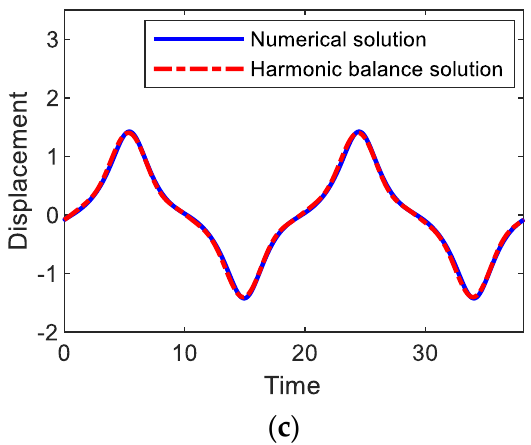
Figure 6. Comparisons between numerical and analytical solutions for ( a ) period-1 T , ( b ) 3 T , and ( c ) 5 T interwell motions, which are obtained when the amplitude and frequency of the base acceleration are given as A = 0.02 and ω = ( a ) 0.82, ( b ) 1.37, and ( c ) 1.65.